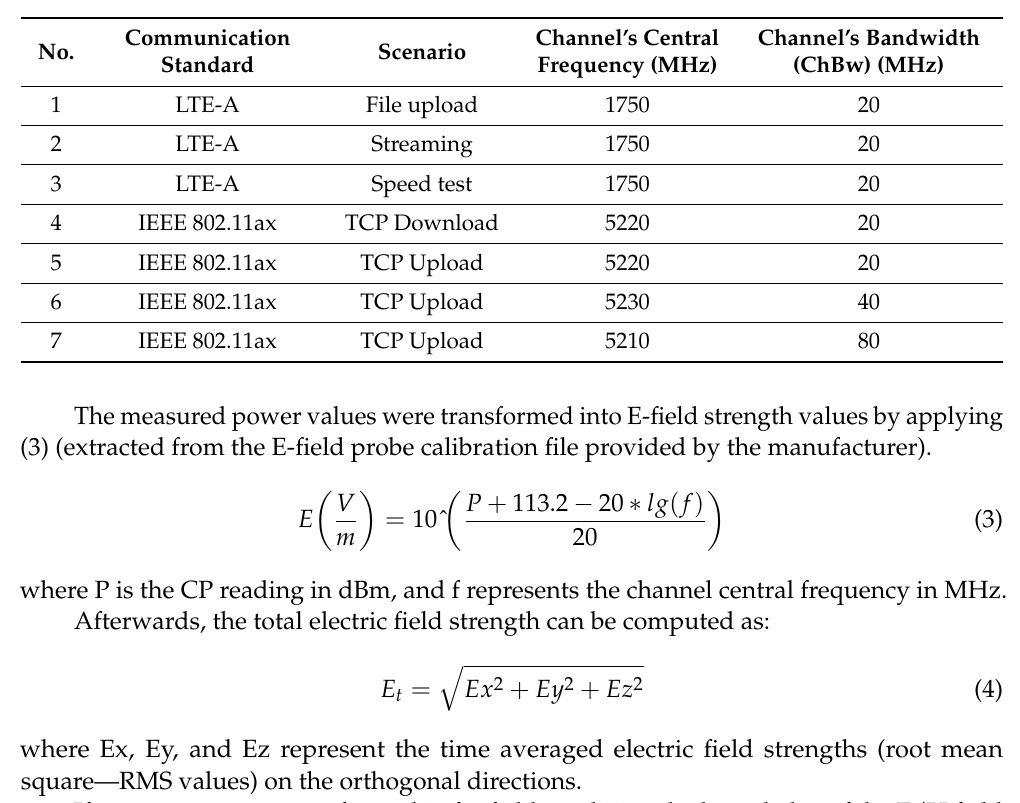
Table 1. Experimental scenarios